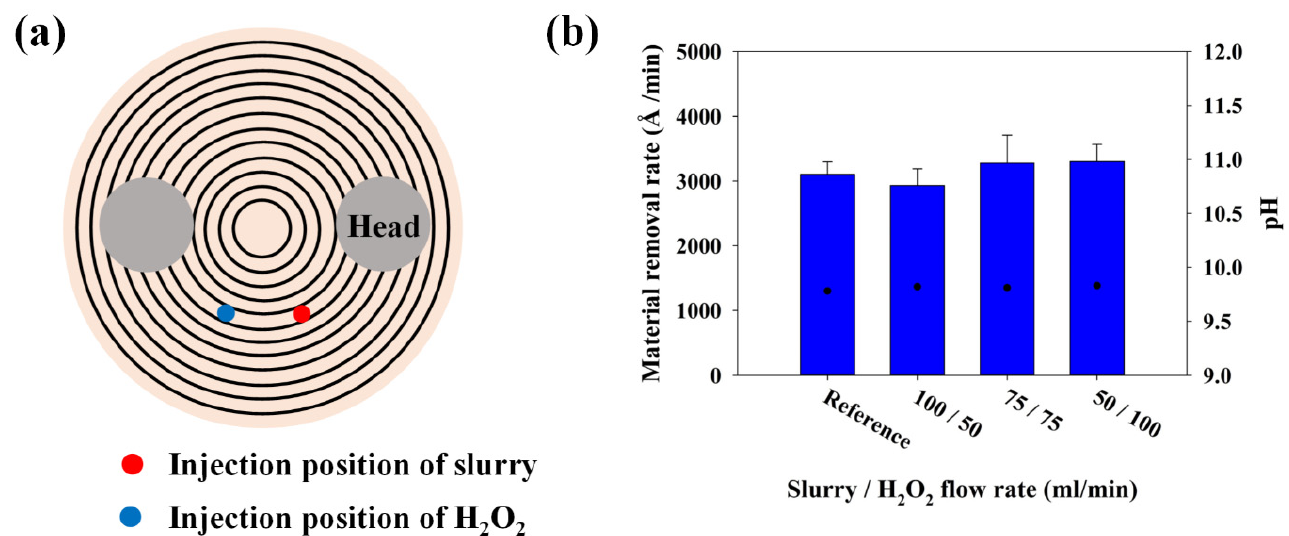
Table 2. MRR and pH of reference and the two-way injection with position; H 2 O 2– slurry.